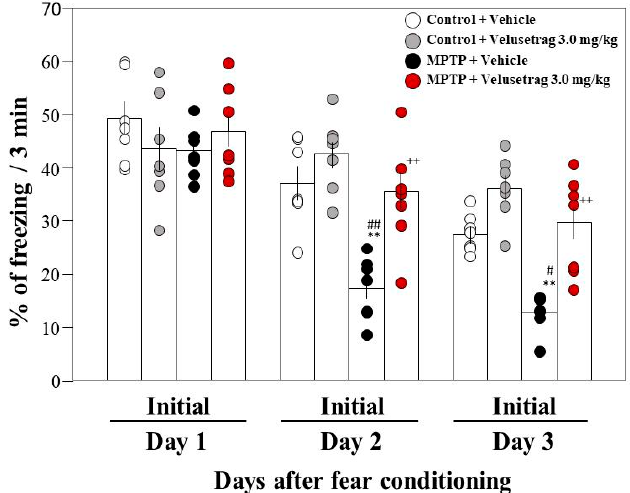
Figure 2. Effects of velusetrag on contextual fear extinction in mice. Mice were given an intraperitoneal injection of velusetrag at a single dose of 3.0 mg/kg in saline containing 1% DMSO or the vehicle only 2 h prior to both extinction training sessions. The data of the control + vehicle and MPTP + vehicle are the same data shown in Figure 1. Data are expressed as the mean ± SEM; n = 7–8. ** p < 0.01 vs. control + vehicle on each day, ++ p < 0.01 vs. MPTP + vehicle on each day, # p < 0.05 and ##